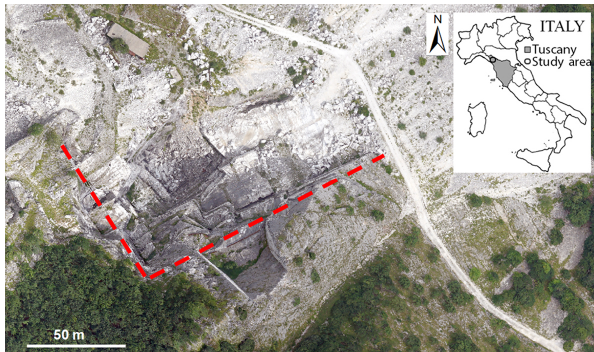
Figure 1. Plan view of the Piastrone open pit with indication of the two principal slope directions (dotted lines). Inset map shows the location of the study